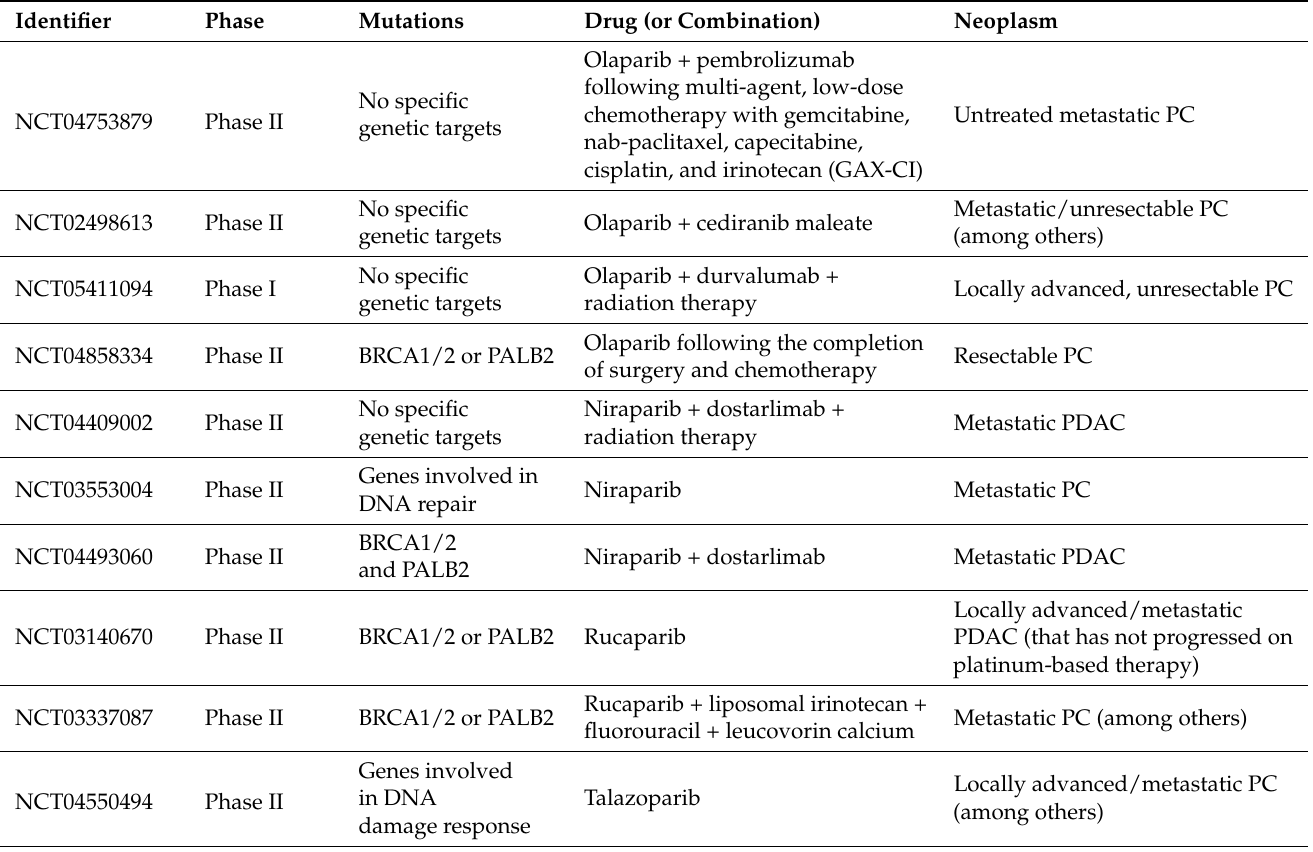
Table 1. Ongoing clinical trials on PARP inhibitors in pancreatic cancer treatment (data derived from https://clinicaltrials.gov/ (accessed on 12 November